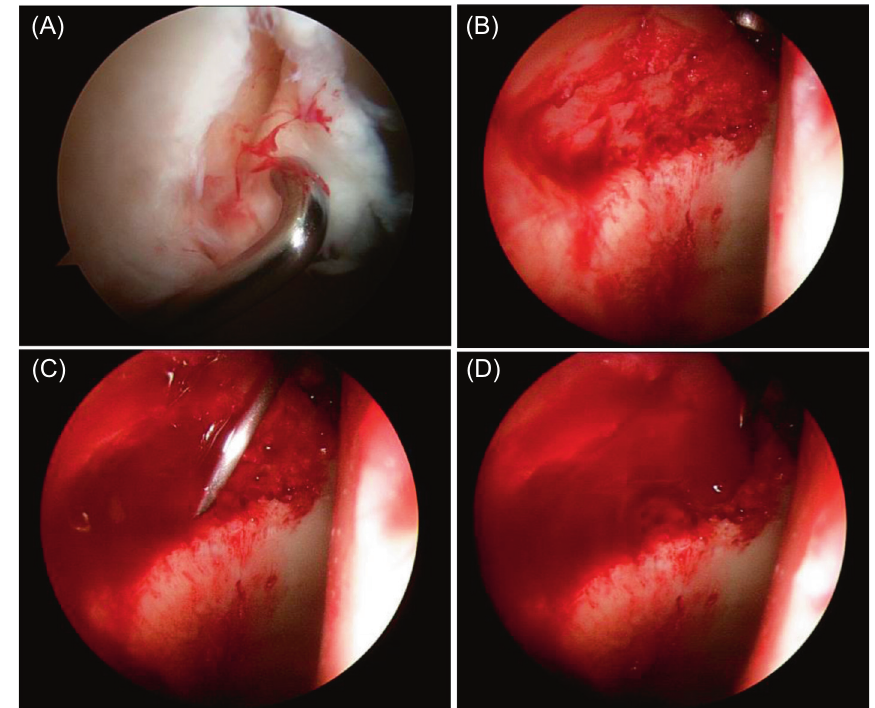
Figure 1. (A) Arthroscopic image of right hip joint showing acetabular chondral delamination before debridment. (B) The chondral defect after debridment and microfracture with bleeding from the penetration holes. (C) Application of BST-CarGel (cid:2) mixture by 18-gauge needle. (D) Covering of the whole defect with BST-CarGel (cid:2) mixture.